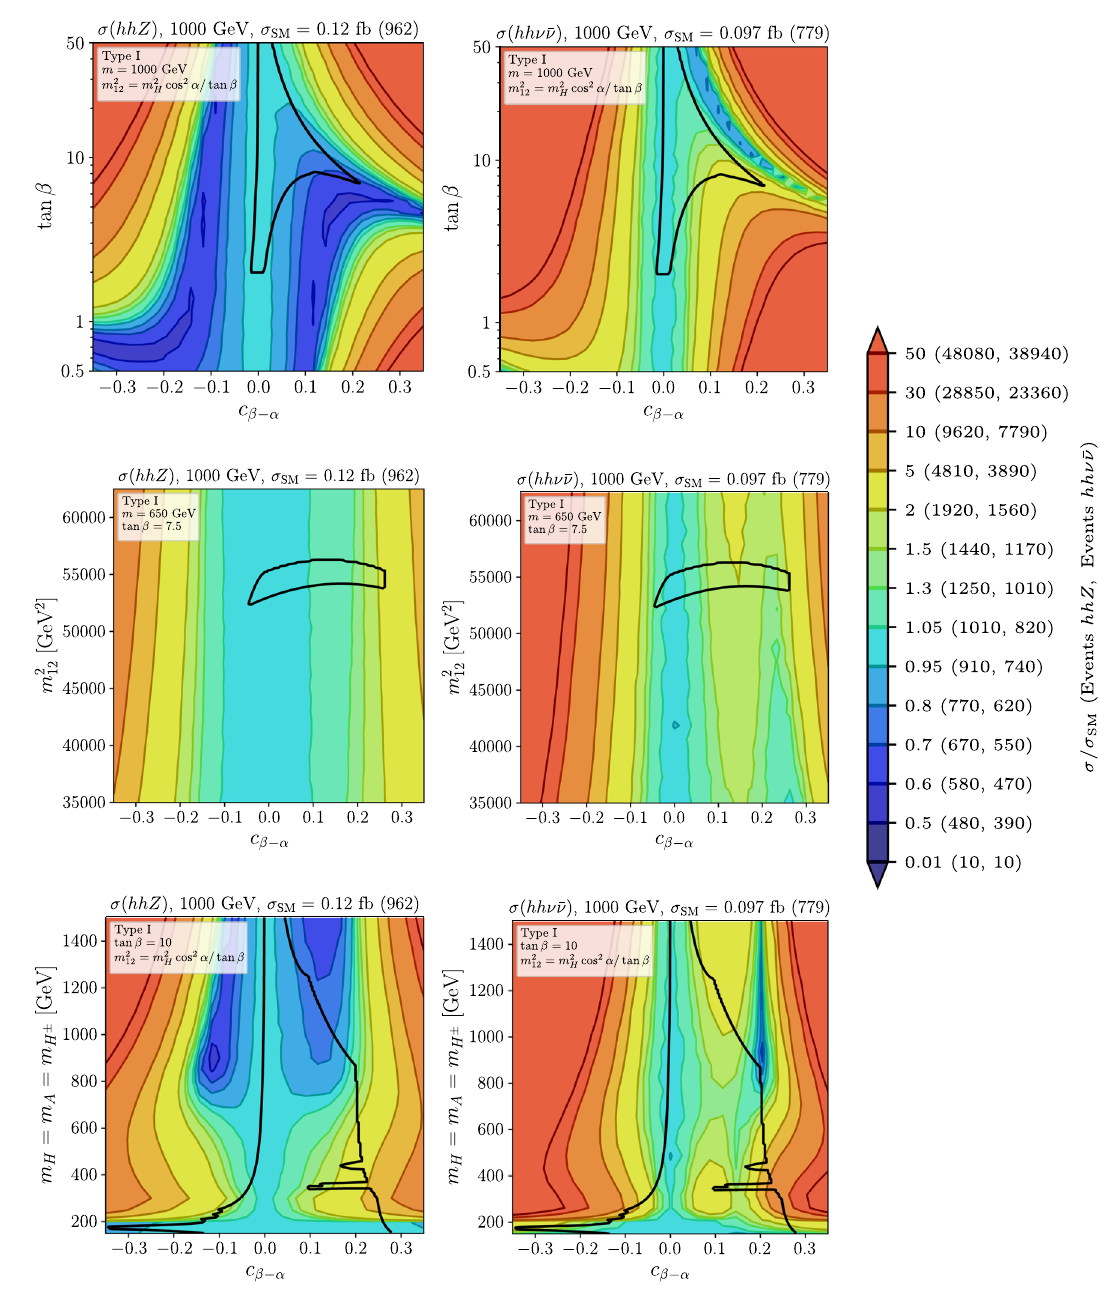
√ s = 1000 GeV for the benchmark planes 1-3 (top to bottom). The